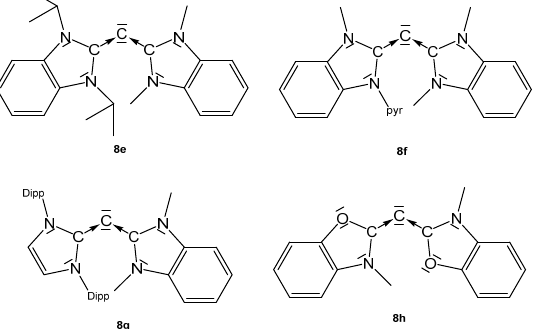
Figure 11. Unsymmetrical CDCs from which transition metal complexes are reported.